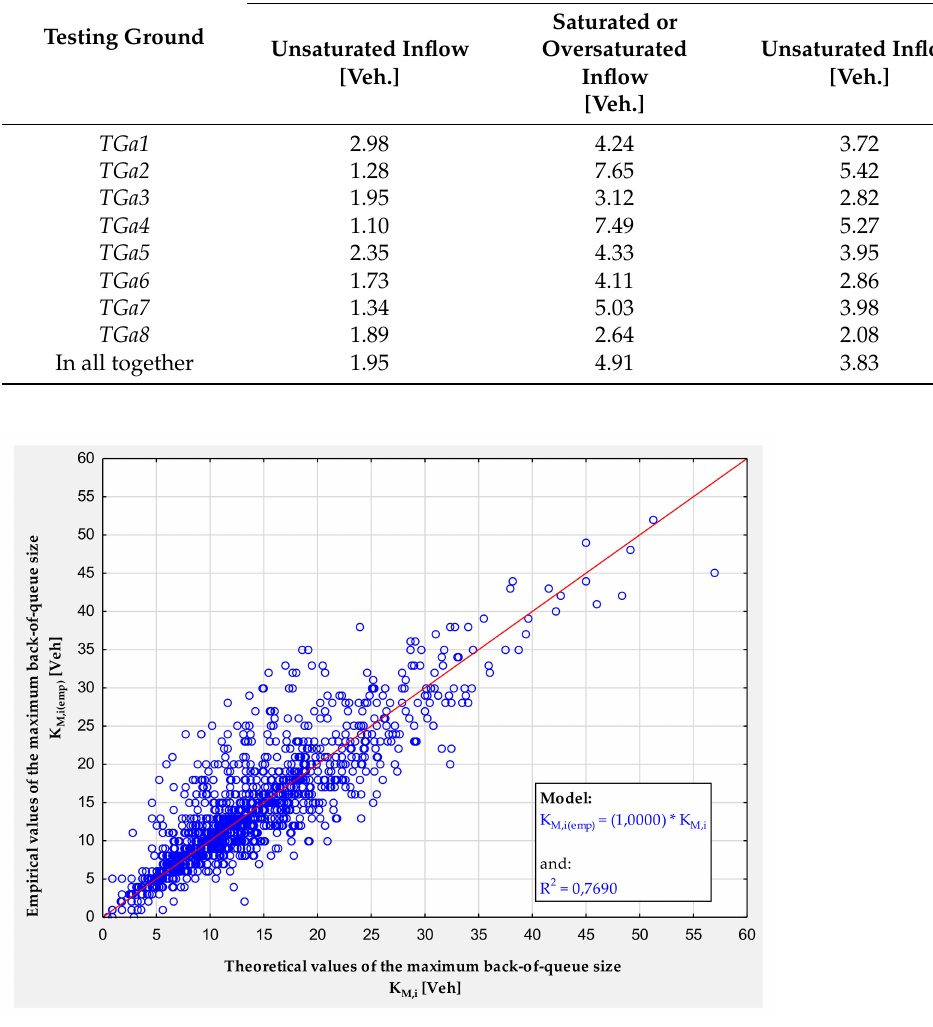
Figure 13. Results of regression and correlation analysis between empirical values of maximum queue size and calibrated theoretical values determined by the proposed